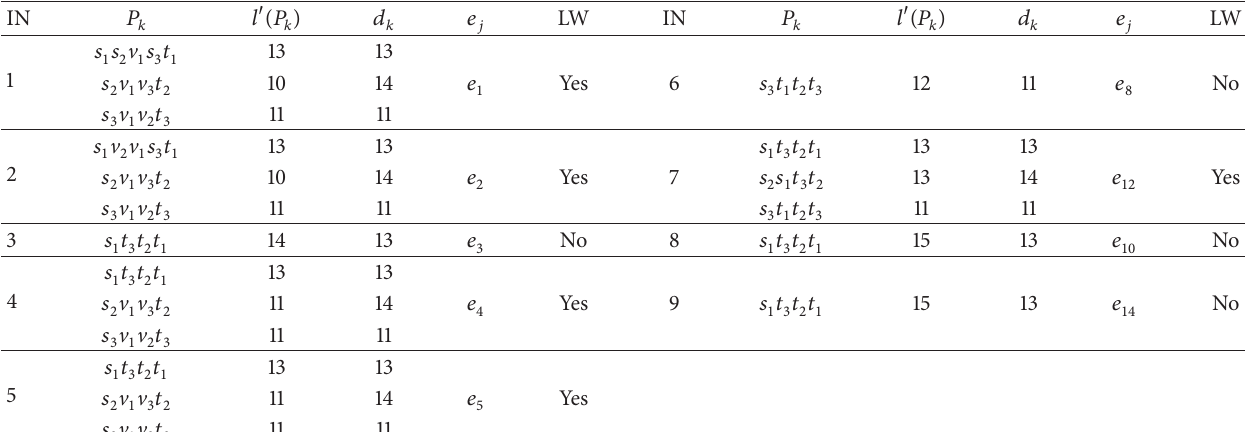
Table 1: Iteration process of Algorithm 16.